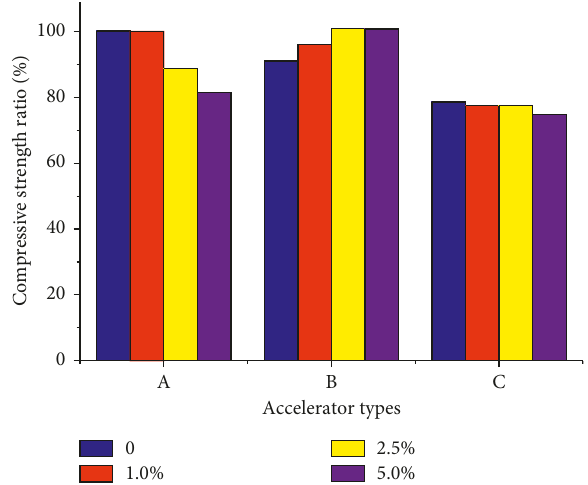
Figure 4: Bar graph of 28d compressive strength ratio of the modified